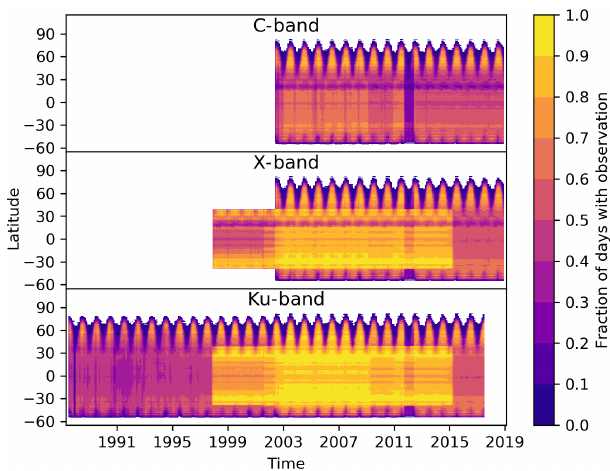
Figure 8. Hovmöller diagrams showing the fraction of days per month with observations for each latitude and month. The number of observations of a latitude and month are counted and then divided by the number of days per month and the number of land grid points at that